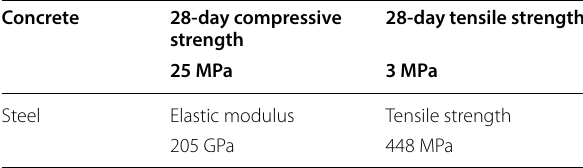
Table 3 Material properties of concrete and steel. Concrete